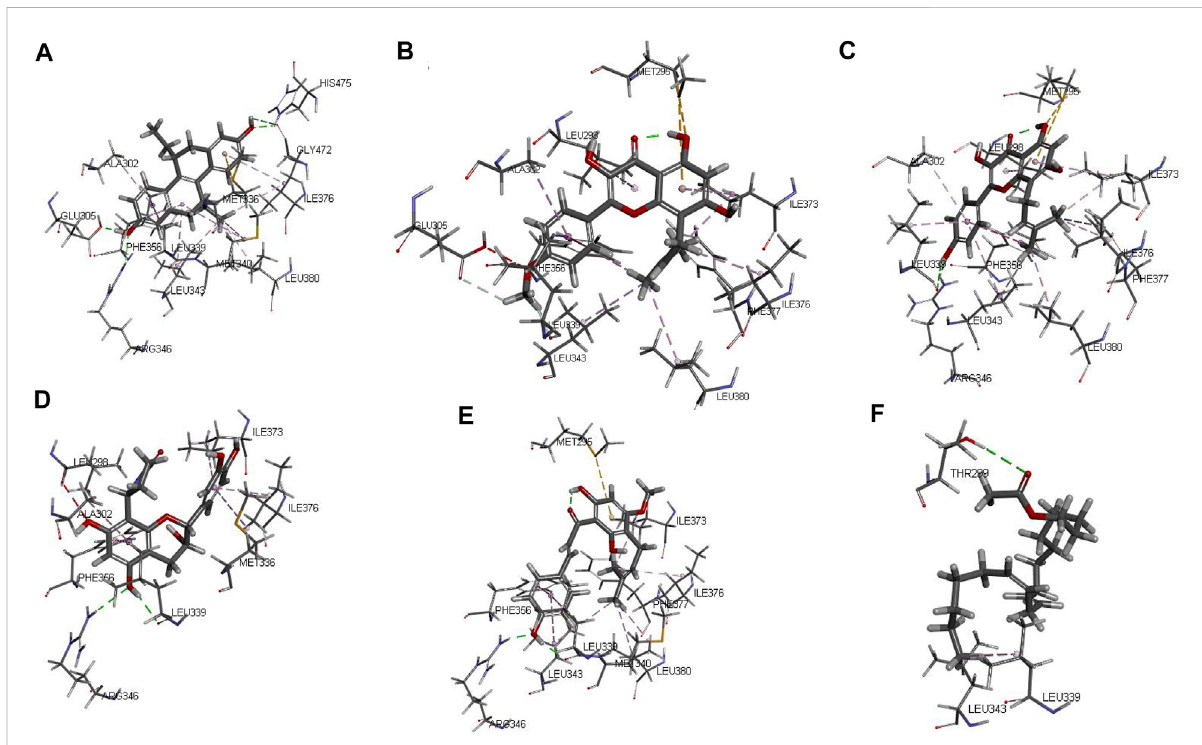
FIGURE 8 The3DinteractionoftheoriginalligandTHC (A) ,anhydroicaritin (B) ,8-isopentenyl-kaempferol (C) ,davalliosideA_qt (D) ,xanthogalenol (E) and linoleyl acetate (F) with